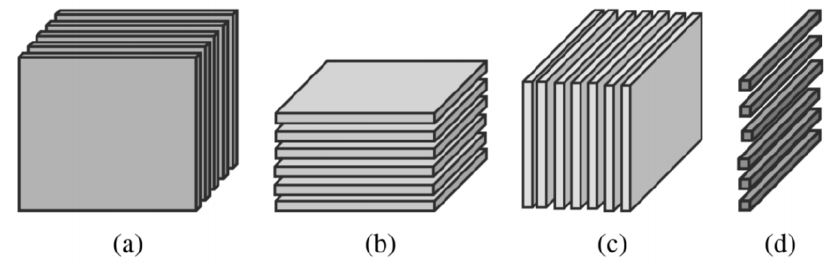
Figure 1. ( a ) Frontal, ( b ) horizontal, and ( c ) lateral slices of a third order tensor. ( d ) A mode-3 tube fibers. The n-mode matrix of a tensor X ∈ R I 1 × I 2 × I 3 ... × I N is denoted by X ( fibers to be the columns of the resulting matrix X (